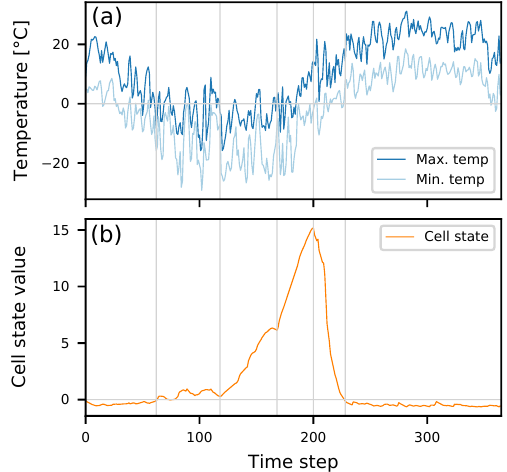
Figure 15. Evolution of a specific cell state in the LSTM (b) com- pared to the daily min and max temperature, with accumulation in winter and depletion in spring (a) . The vertical grey lines are in- cluded for better